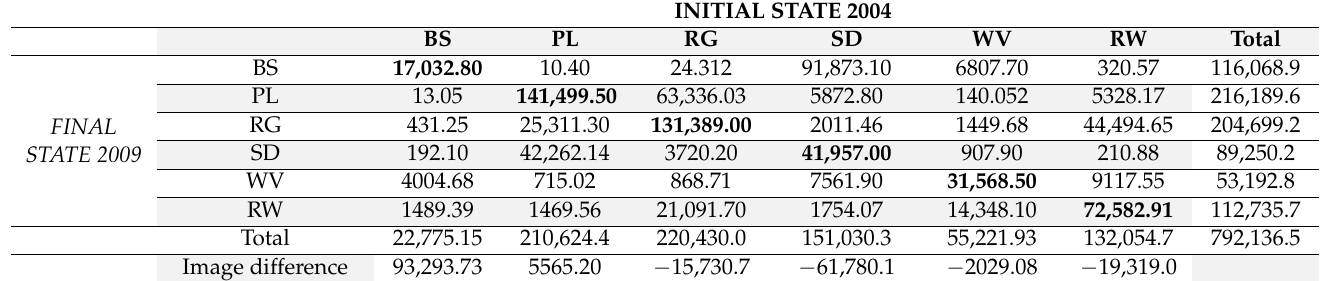
Table 6. Change matrix of the rainfed agriculture and other LULC types of North Darfur State in hectares from 2004 to 2009. The bold values in the change matrix indicate unchanged land types between the initial and final years.